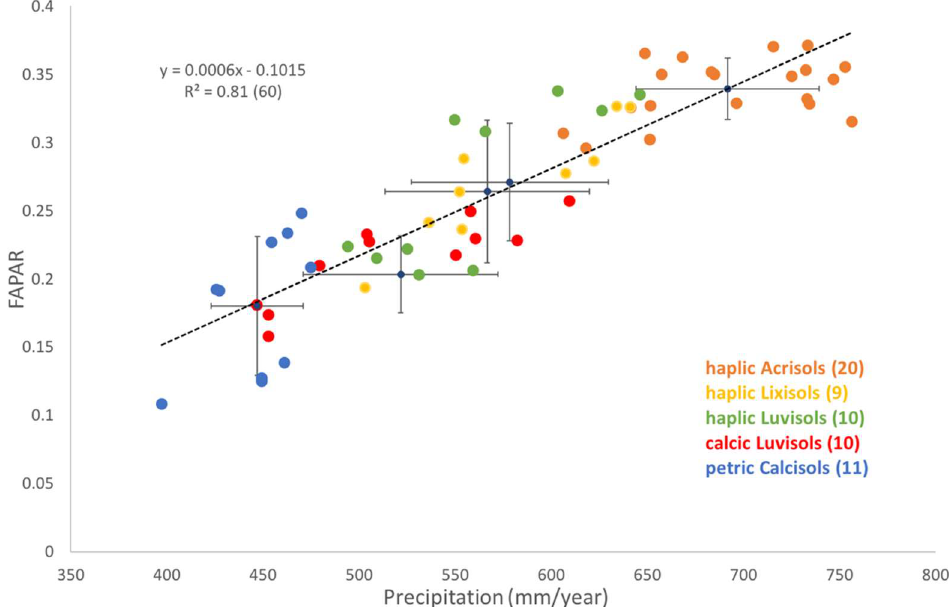
Figure 2. Linear correlation between multiyear averages of Fraction of Absorbed Photosynthetically Active Radiation (FAPAR) and precipitation at each grassland site (black dotted regression line). The sites are grouped by soil type (haplic Acrisols, Lixisols, Luvisols, Calcisols, and Calcic Luvisols). The black bars represent the standard deviation in precipitation and FAPAR per soil type.